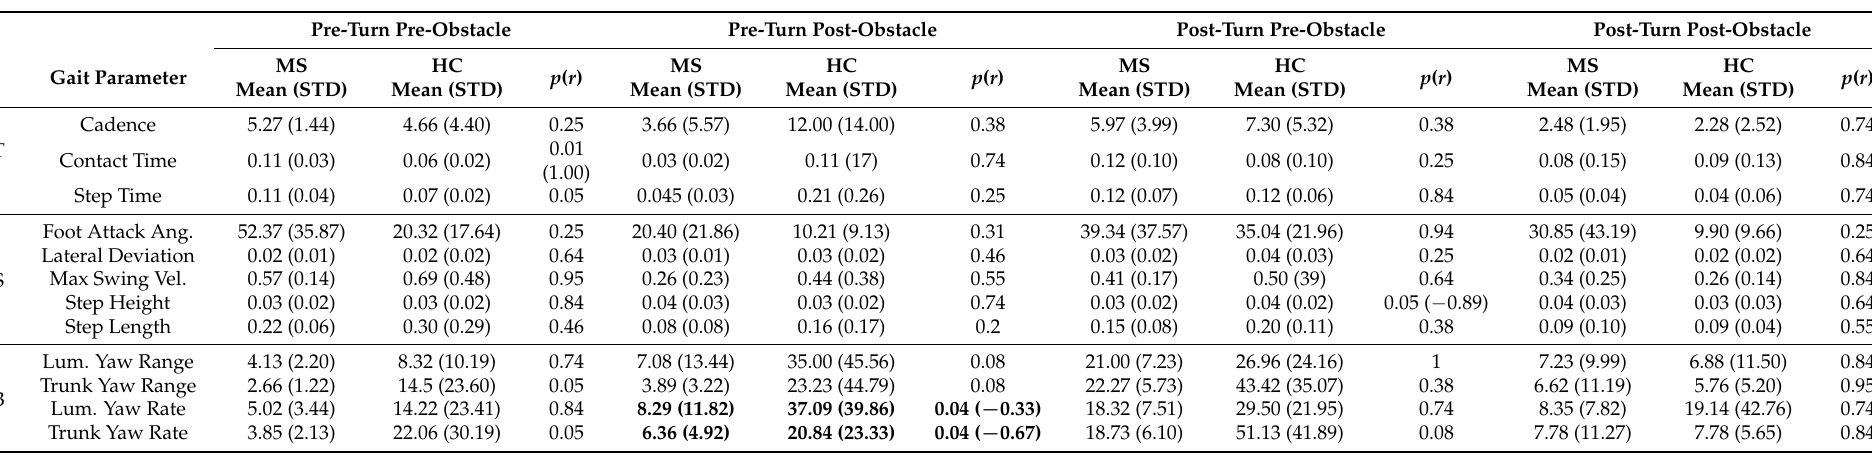
Table 6. Comparisons of gait variability between PwMS (MS) and controls (HC) during each phase of OW task. p -values ( p ) are reported for each comparison with effect sizes ( r ) indicated for significant